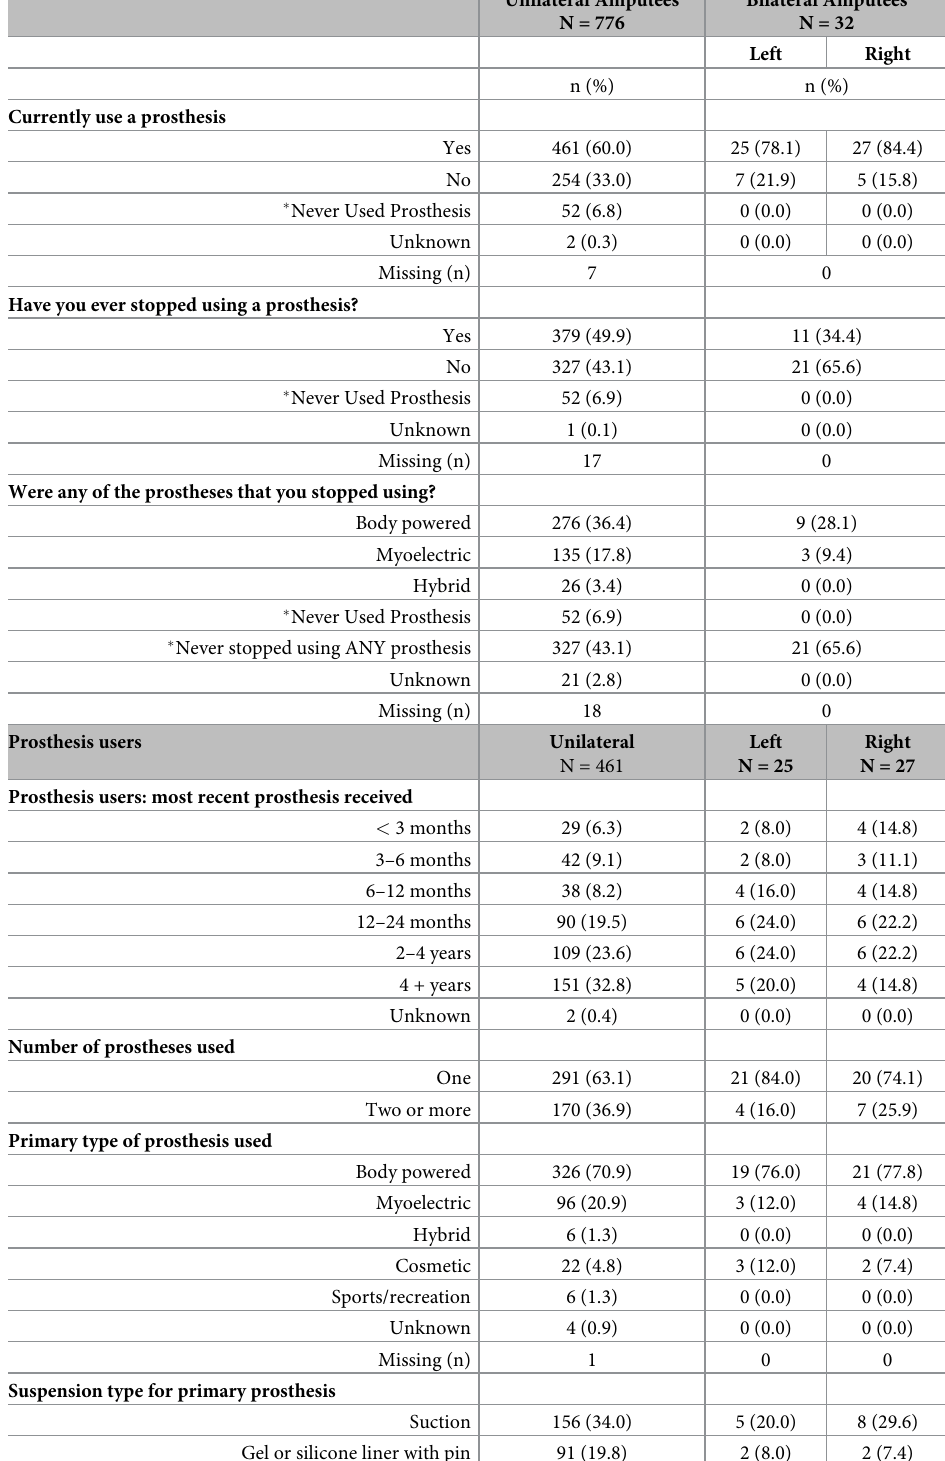
Table 3. Type of prostheses, terminal devices and suspension methods: Comparison of unilateral and bilateral